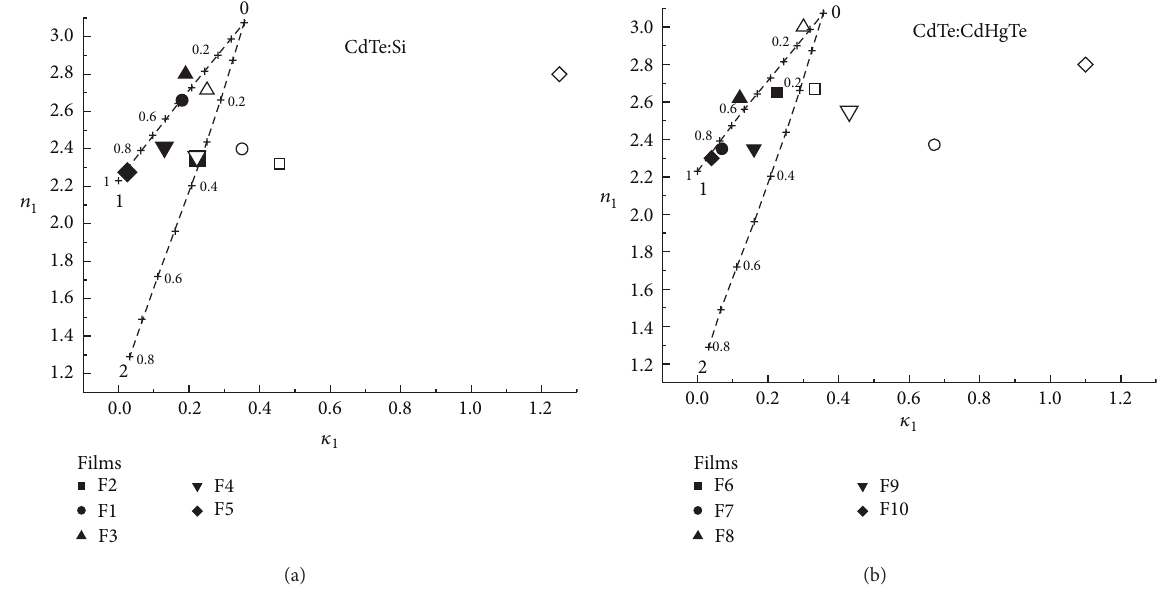
Figure 5: Refractive index 𝑛 1 and index of extinction 𝜅 1 of outer layer of cadmium telluride films (symbols), grown on silicon (a) and CdHgTe (b) substrates. Curves present optical constants’ change of the mixtures CdTe + oxide (1) and CdTe + air (2). Numbers near markers specify the volume fraction of oxide and air in mixtures.